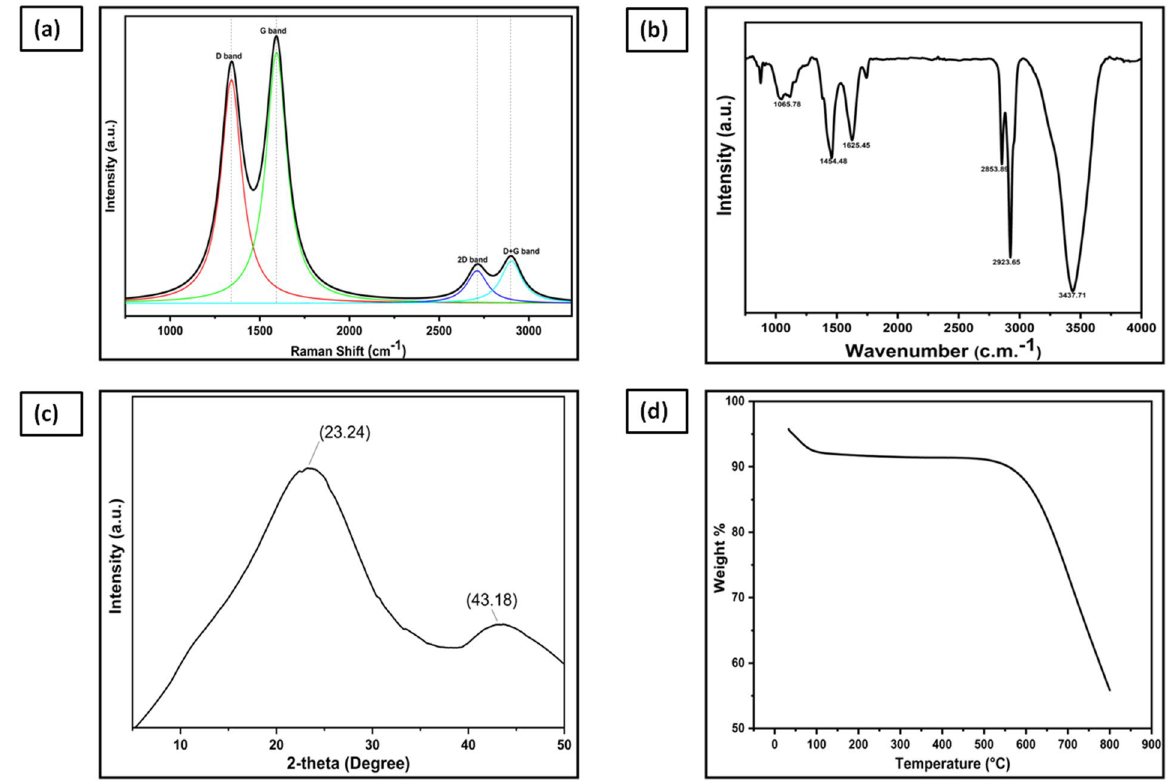
Figure 2. ( a ) Raman spectra of GNs, ( b ) FT-IR spectra of GNs, ( c ) XRD spectra of GNs, ( d ) TGA graph of